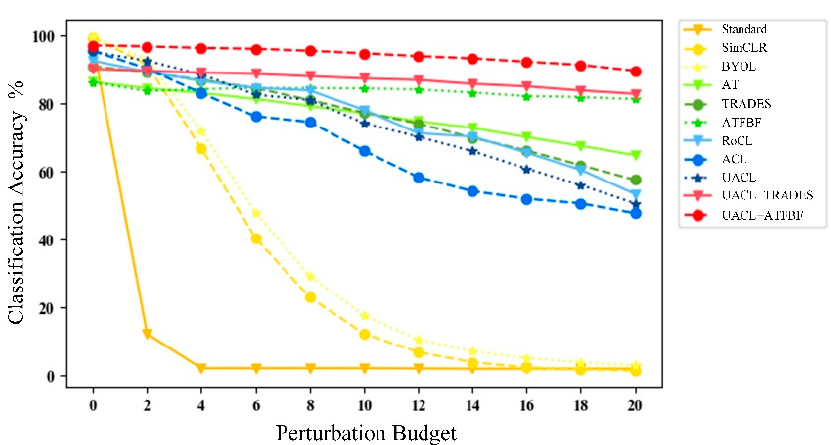
Figure 7. Robust accuracy of MSTAR models trained with adversarial defense methods against adversarial attacks ( L ∞ PGD) with different strengths (/255).